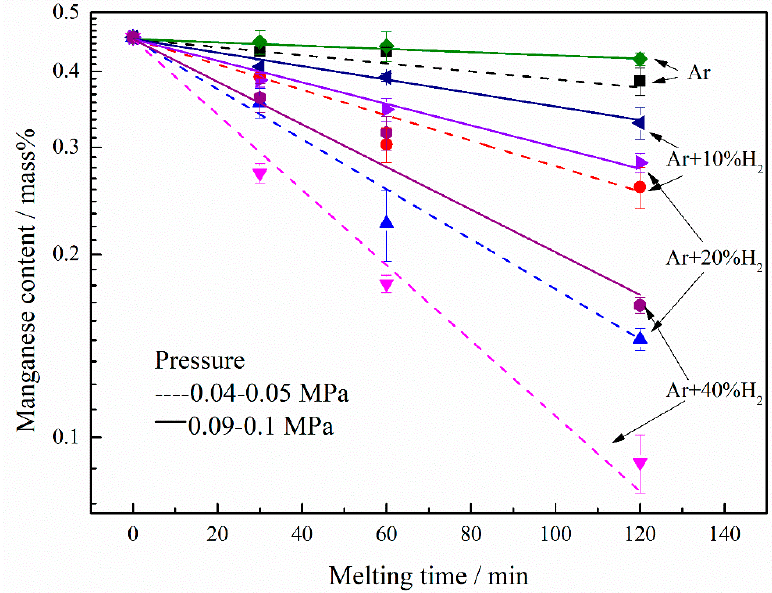
Figure 2 Change in the manganese content of liquid nickel during HPAM at 0.04–0.05 and 0.09–0.1 Figure 2. Change in the manganese content of liquid nickel during HPAM at 0.04–0.05 and MPa. 0.09–0.1